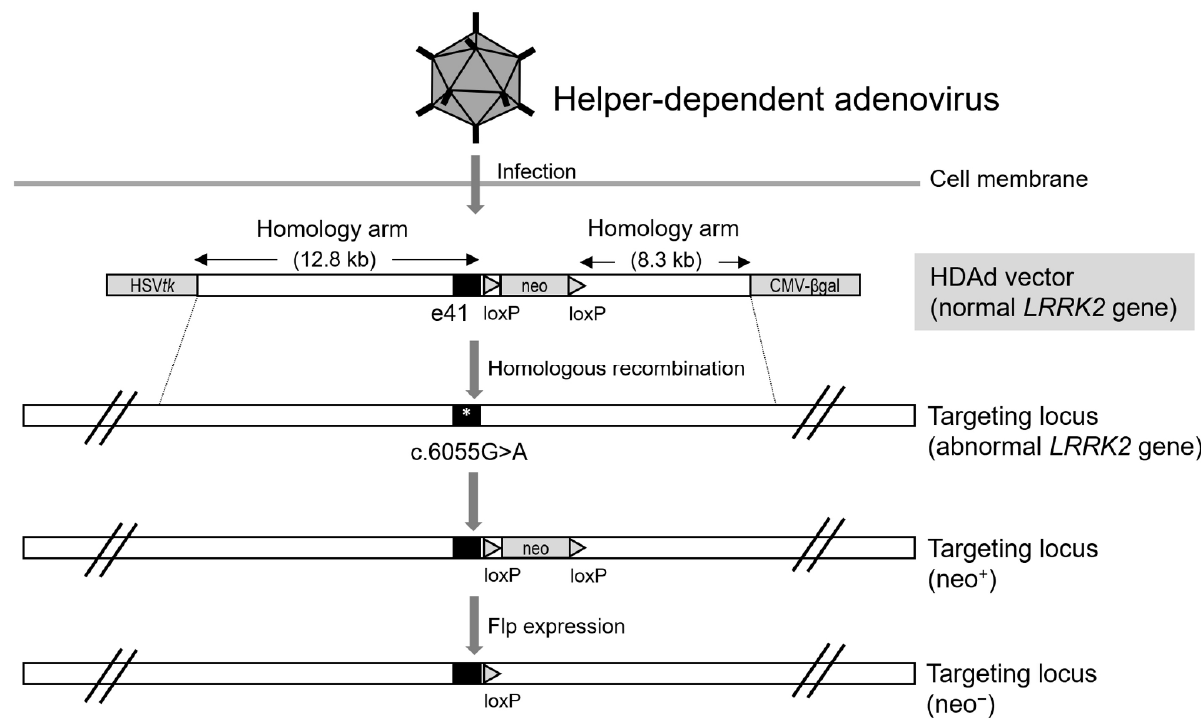
Figure 3. HDAd vector ‐ mediated LRRK2 gene correction. The targeting of the HDAd vector adjacent to the LRRK2 gene mutation, LRRK2 c.6055G>A by homologous recombination.